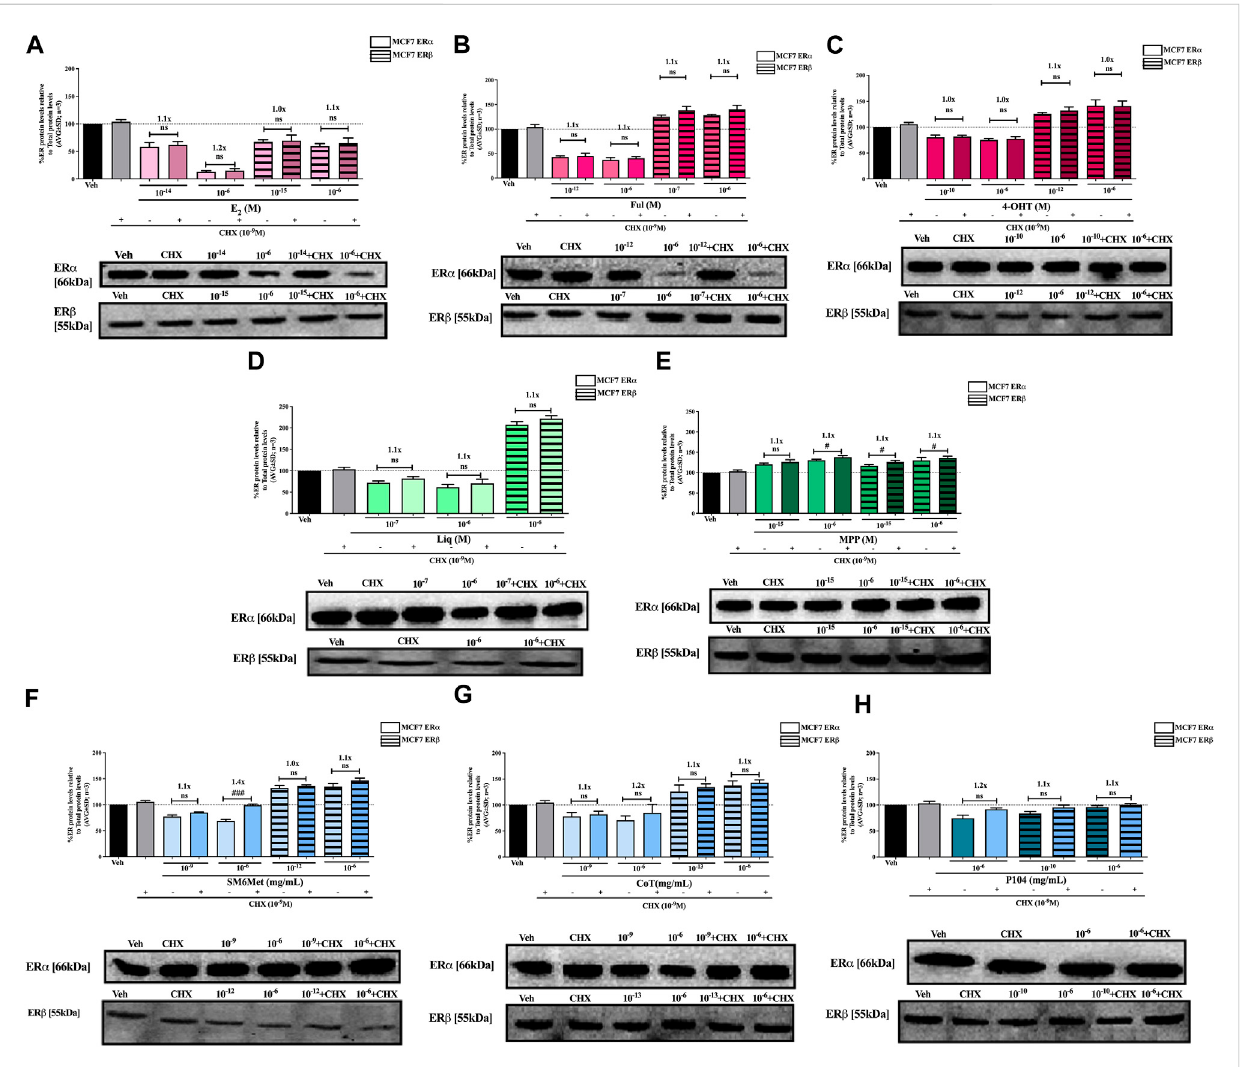
FIGURE 4 Effect of CHX, a protein synthesis inhibitor, on the modulation of ER α and ER β protein levels in MCF7 cells. MCF7 cells were steroid starved for 24 h and then treated with either vehicle (DMSO) or LogIC 50 (from Figure 2; Table 2 with µg/ml converted to M) and saturating (1 μ M) concentrations of (A) E 2 or the SOCs, (B) fulvestrant (Ful) or (C) 4-OH-tamoxifen (4-OHT), or the ER subtype selective ligands, (D) liquiritigenin (Liq) or (E) methyl-piperidino- pyrazole (MPP), or LogIC 50 (from Figure 2 in µg/ml) and saturating (10 − 6 μ g/ml) concentrations of the Cyclopia extracts, (F) SM6Met, (G) cup of tea (CoT) or (H) P104 in the presence or absence of 1 nM CHX for another 24 h, after which the effect of ± CHX on ER α and ER β protein levels were determined using Western blot. The western blots shown as insertare representativesofthree independentexperiments. Forquanti fi cation, theintensity oftheER α andER β bandsweredeterminedwithMyImageAnalysissoftware,afterwhichtheobtainedvalueswerenormalizedtototalproteincontentand expressed as a percentage (AVG ± SD) of DMSO, which was set at 100%. Fold-change is indicated above the bars. Statistical analysis was done using a two-tailed t -test to establish signi fi cant differences due to addition of CHX ( # p < 0.05, ## p < 0.01 and ### p <